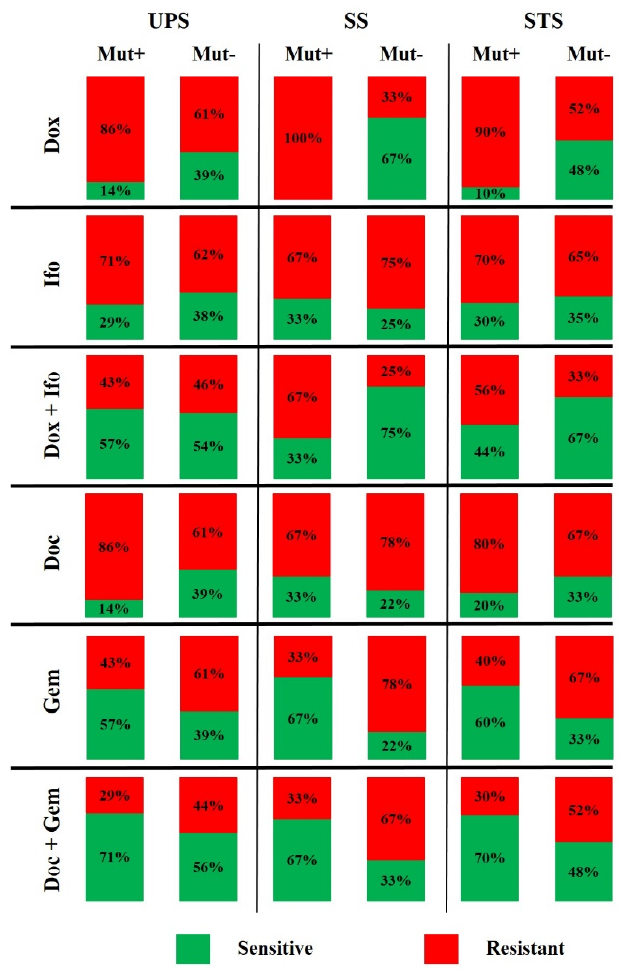
Figure 3. Histograms of partial ratio (%) of sensitivity and resistance to the drug primary STS cul- tures depending on the somatic mutational status of apoptosis activation pathway genes. depending on the somatic mutational status of apoptosis activation pathway